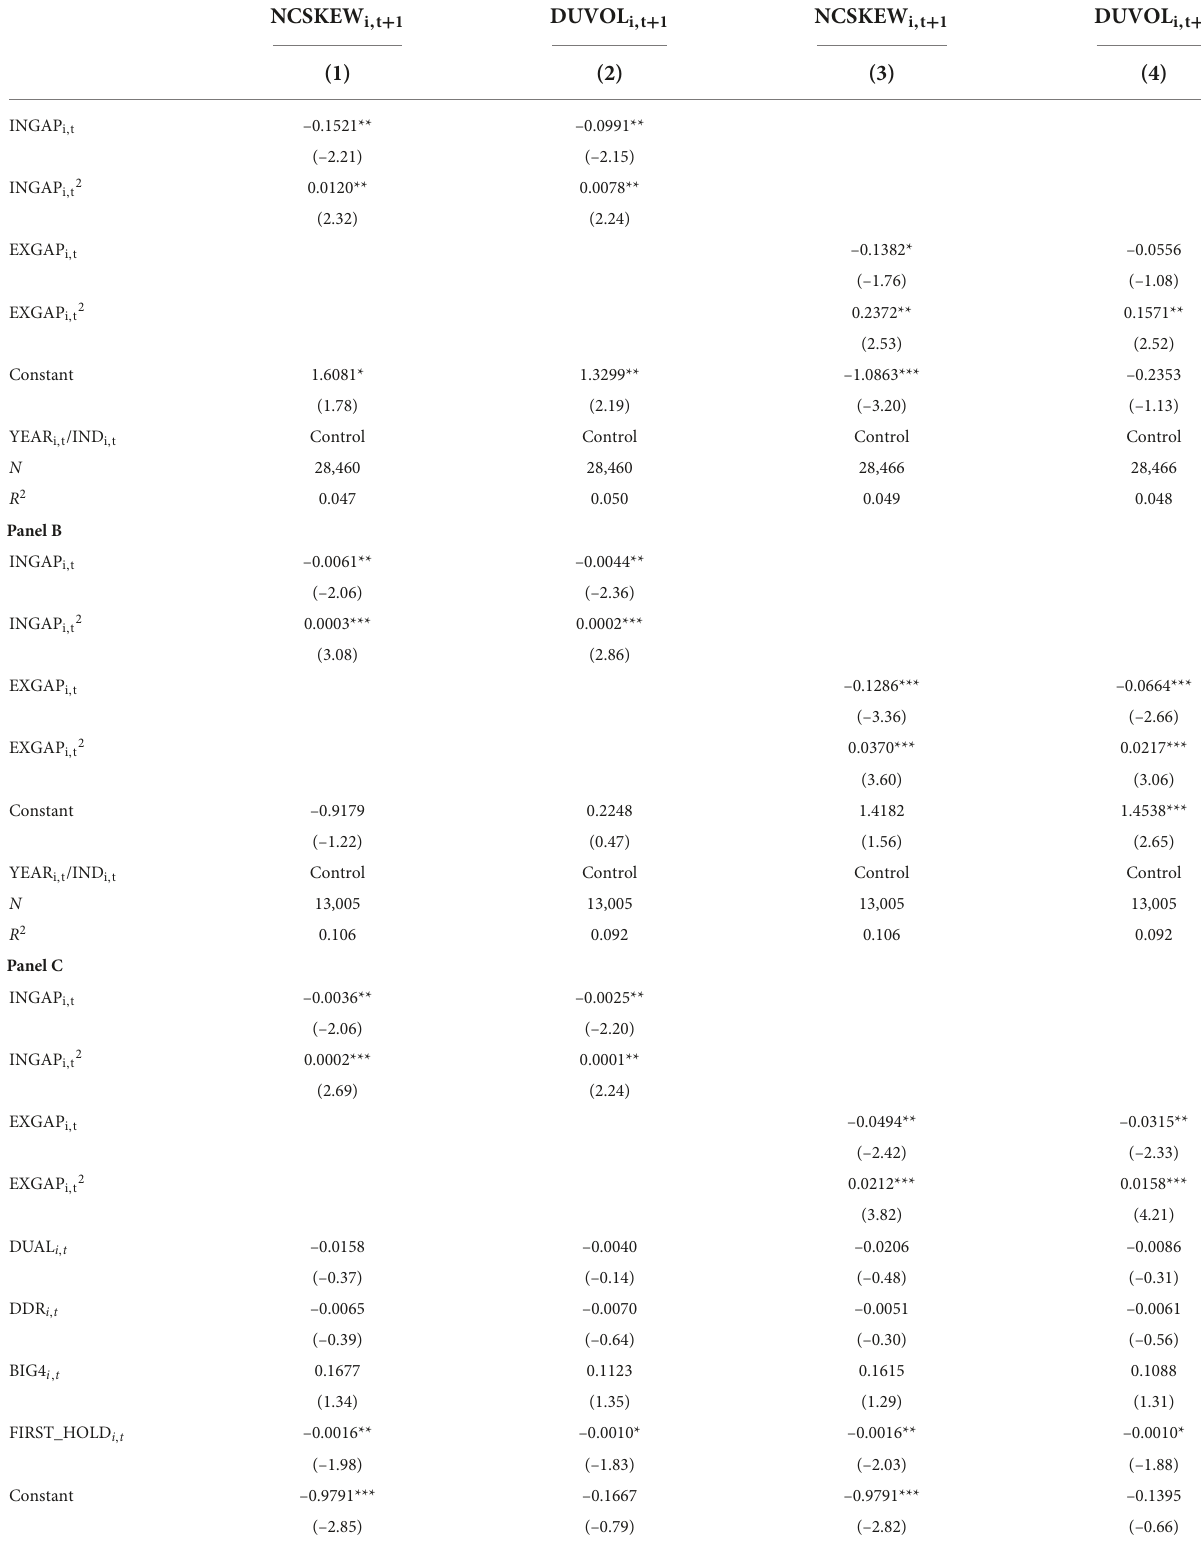
TABLE 5 Regression analysis to robustness